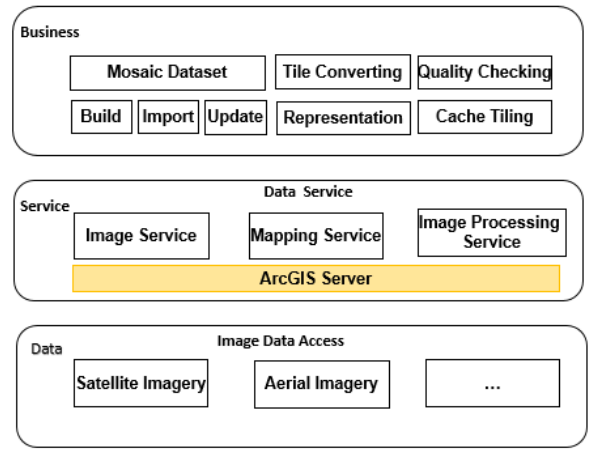
Figure 1. Software architecture